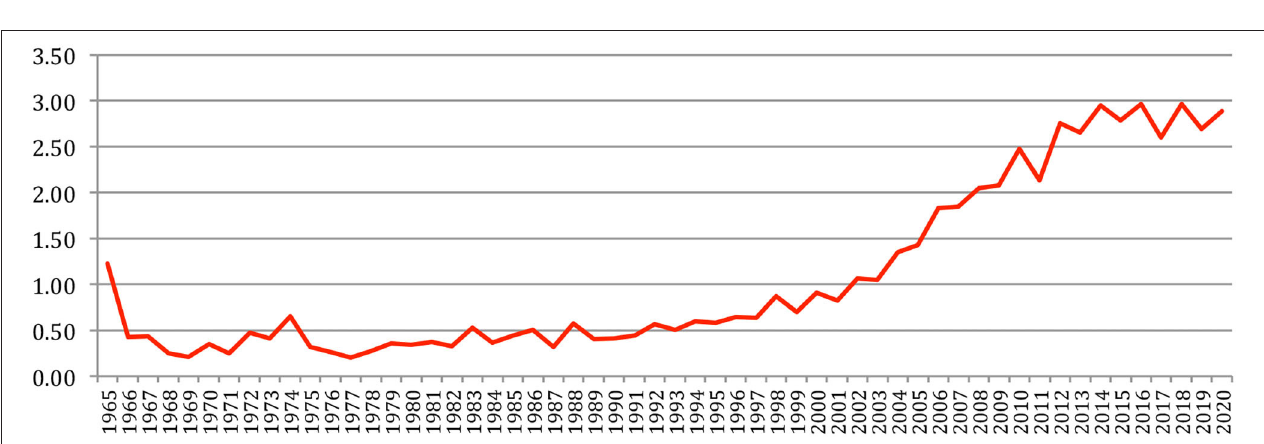
FIGURE 52 | Evolution of the ratio between the number of mentions of Language Resources in papers and the number of papers over the